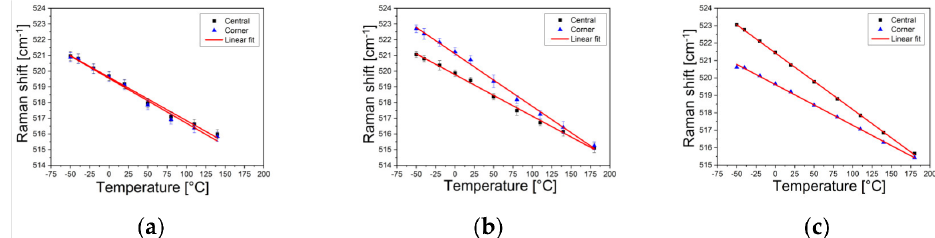
Figure 8. Central [6, 6] (squares) and corner (triangles) [1, 1] Raman shift recorded at temperatures from − 50 to 180 ◦ C with the Si_Unmounted chip ( a ), the A_AuSn_p sample ( b ) and the A_AuSn sample ( c ). Table 3. Linear fit parameters of the Raman peak position signal of the chips at different temperatures. R